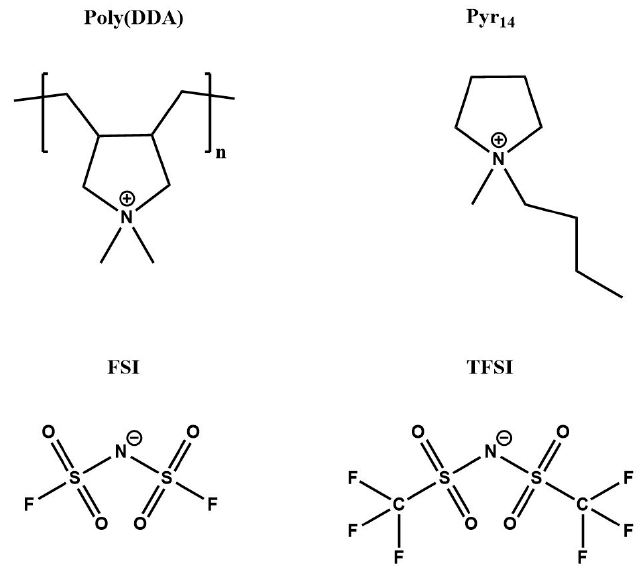
Figure 1. Chemical structures of poly(DDA), Pyr14, FSI and TFSI.